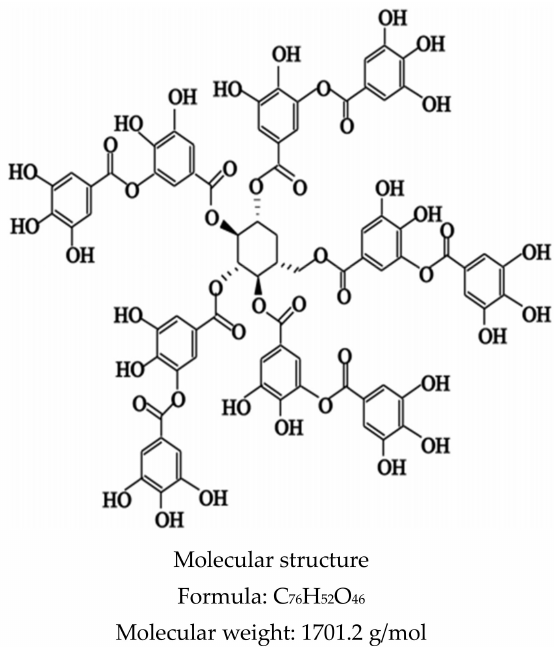
Figure 1. Structure and properties of Tannic